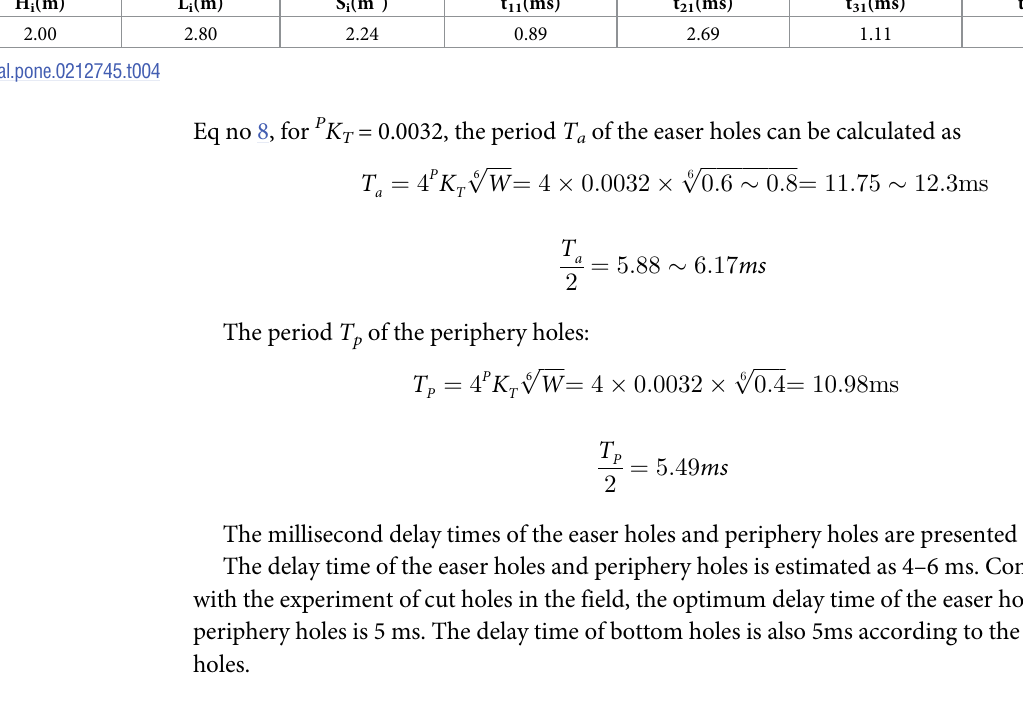
Table 4. Millisecond delay times for cut holes. Row No.